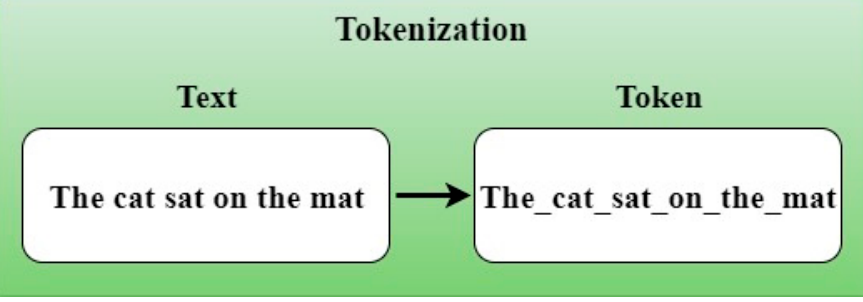
Figure 3. Example of output of tokenization.